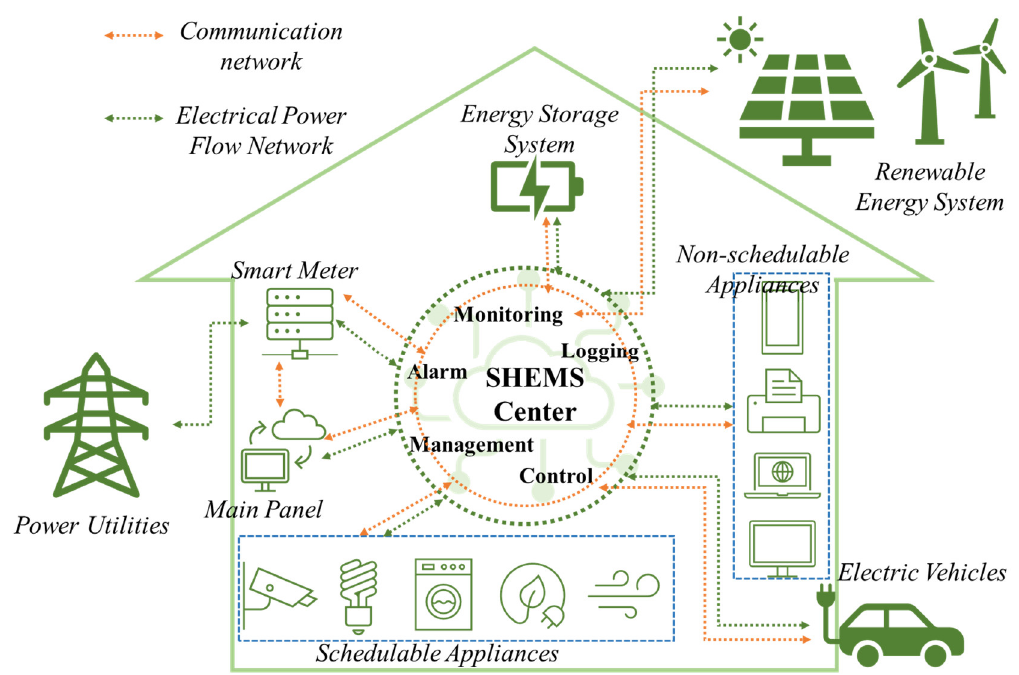
Figure 3. The overall architecture of a representative SHEMS reprinted with permission from Ref. [26] .